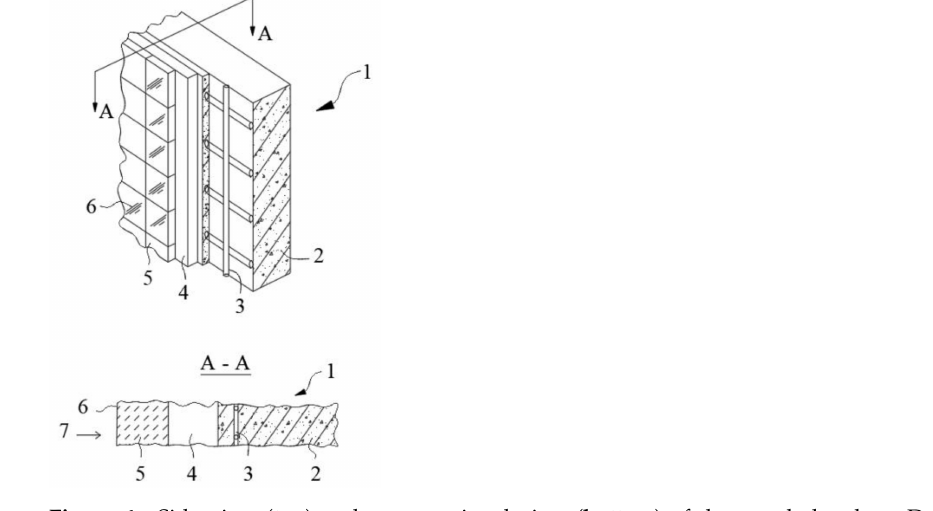
Figure 4. Side view ( top ) and cross-sectional view ( bottom ) of the panel absorber. Denotations: 1—panel absorber, 2—bearing layer, 3—reflective layer, 4—absorber layer, 5—outer protective layer, 6—electromagnetic waves incidence surface, 7—direction of electromagnetic waves incidence (after